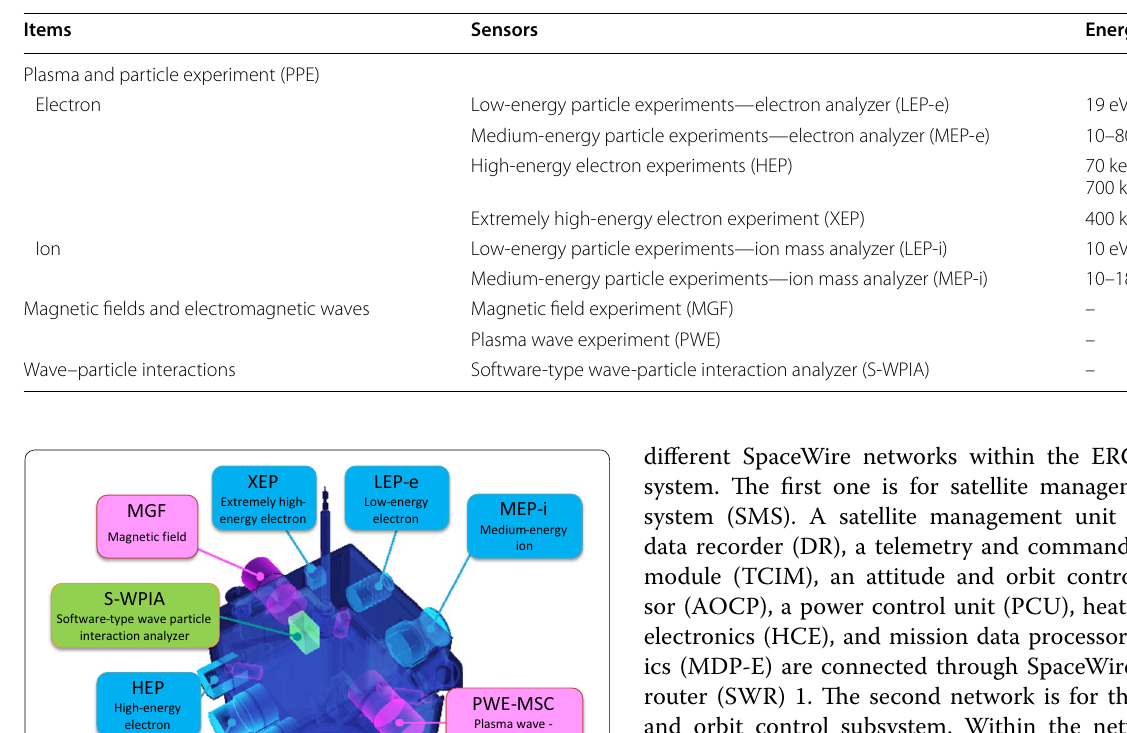
Table 1 Mission